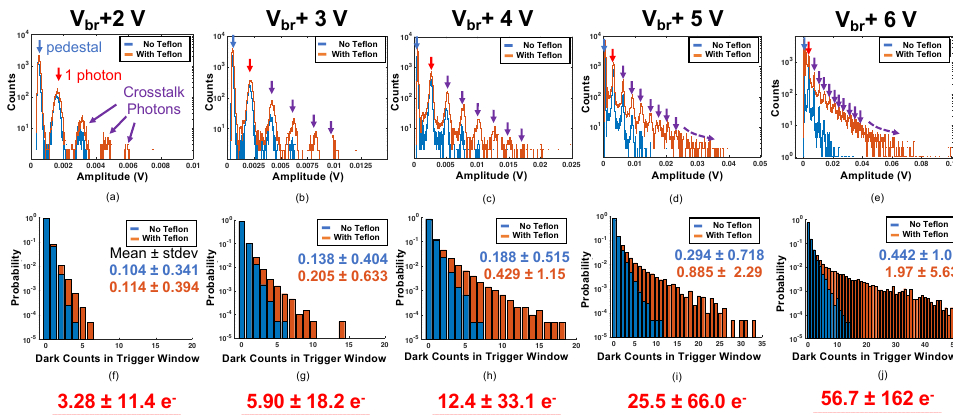
Figure 6. Dark noise spectra for a Hamamatsu S13360-6075CS SiPM as a function of overvoltage (increasing 2 V to 6 V from left to right) is shown in the above figures ( a – e ). The same distributions, converted into number of noise counts/photons, is shown in the figures below ( f – j ), along with point estimates for mean and standard deviation of the distributions. Below each configuration, the mean number of expected noise photons within a 15 ns region of interest (taken from point estimates in ( f – j )), for six sided readout of the same sensor and operating voltage, is shown in red.